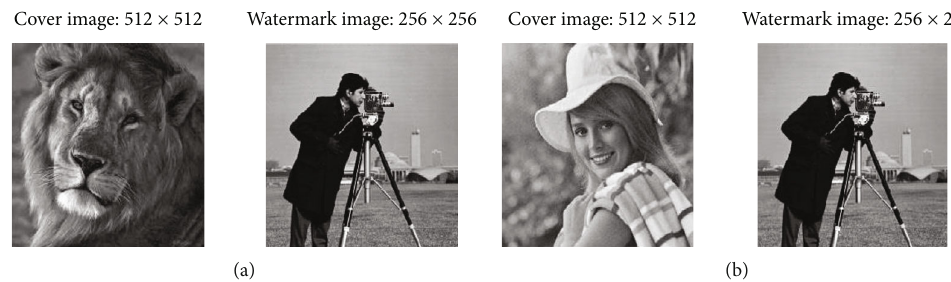
Figure 4: Emended watermark images: (a) own image and (b) standard image.